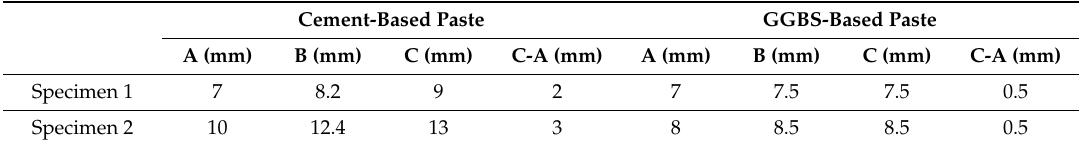
Table 5. Le Chatelier soundness test